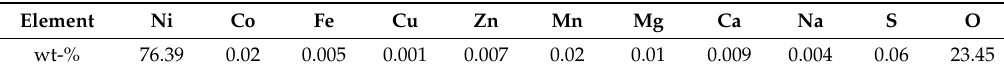
Table 4. Chemical composition of the NiO powders